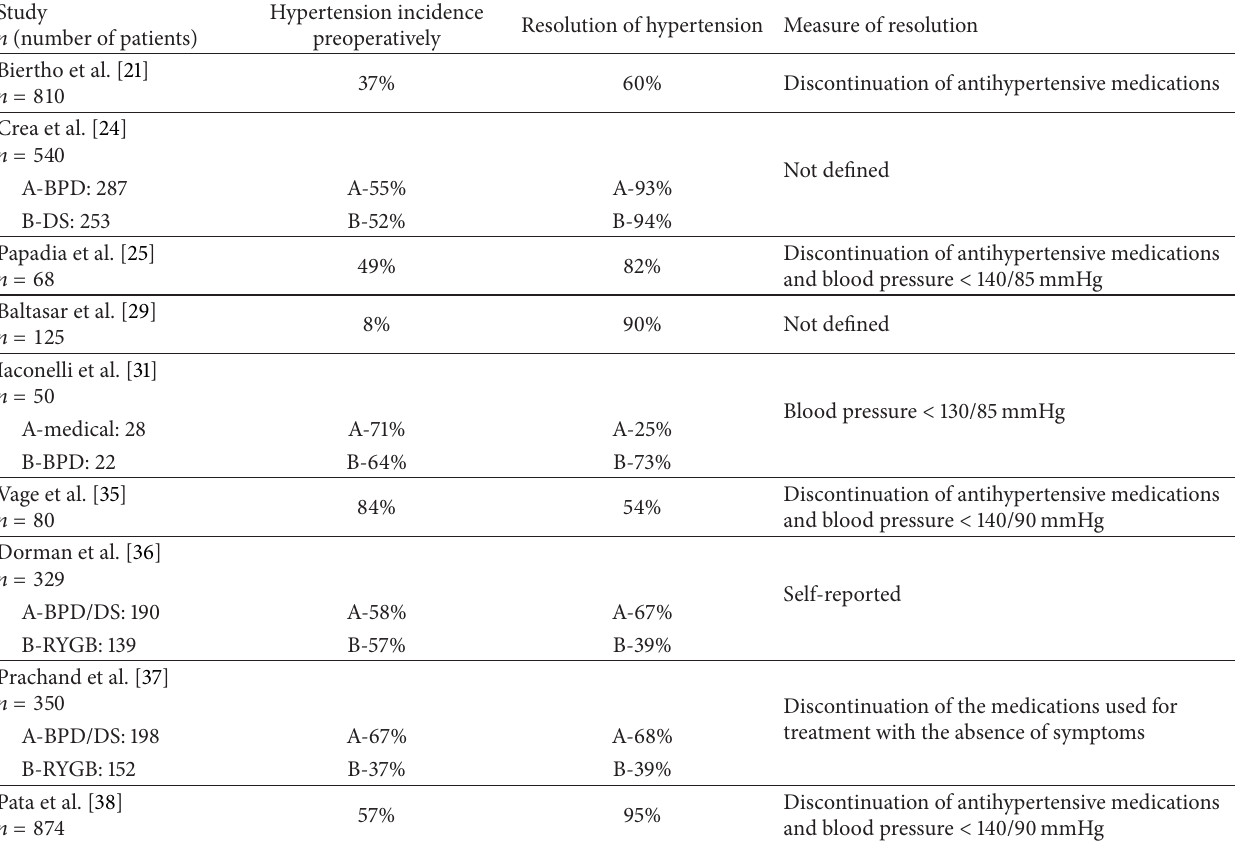
Table 2: Effect of biliopancreatic diversion with duodenal switch on